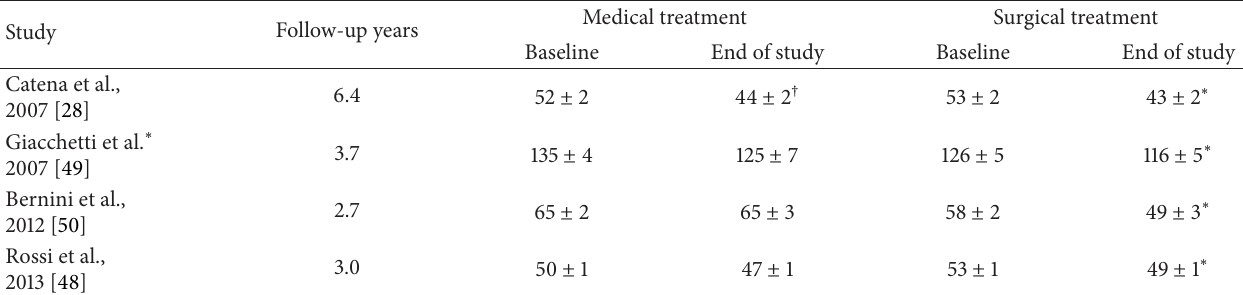
Table 2: Summary of results obtained in studies that evaluated the long-term response of left ventricular mass to either medical treatment or surgical treatment in primary